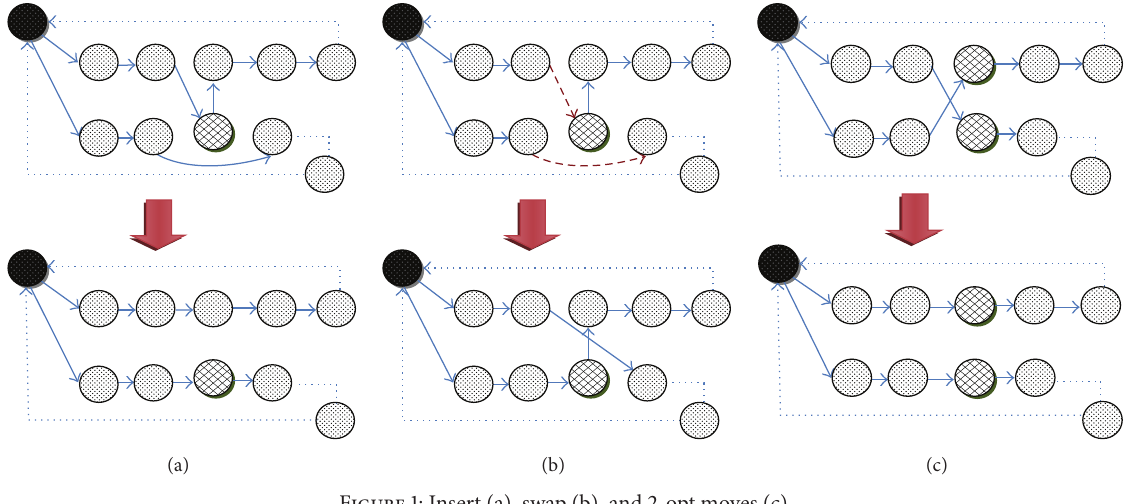
Figure 1: Insert (a), swap (b), and 2-opt moves